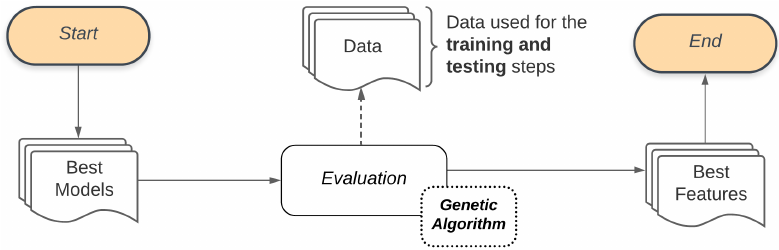
Figure 5. Feature selection general